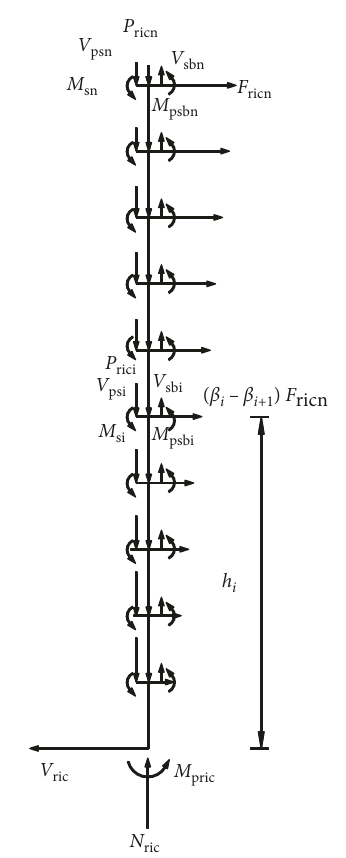
Figure 6: Free body diagram of the right interior column.